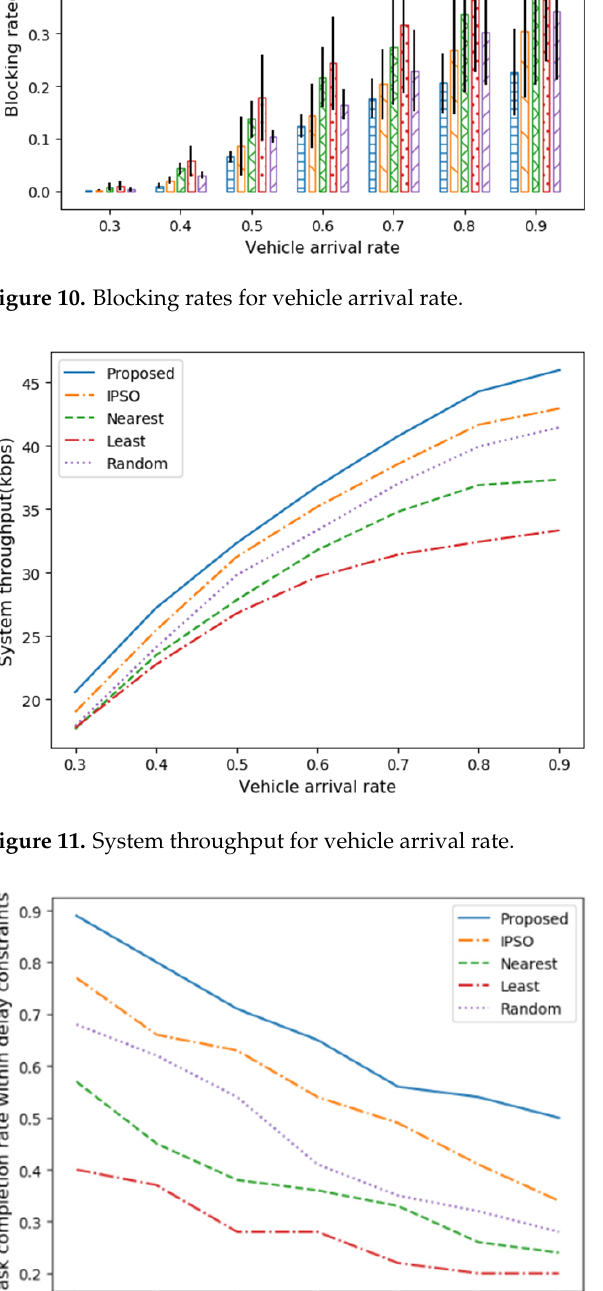
Figure 12. Task completion rates for vehicle arrival rate.